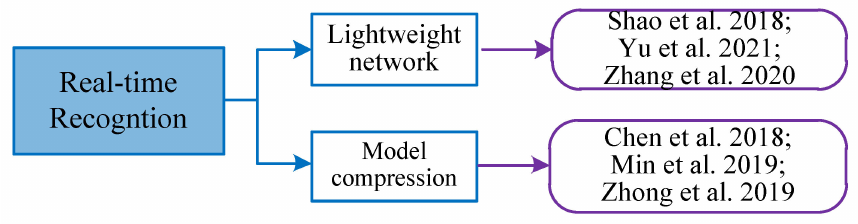
Figure 22. The real-time recognition in SAR ATR